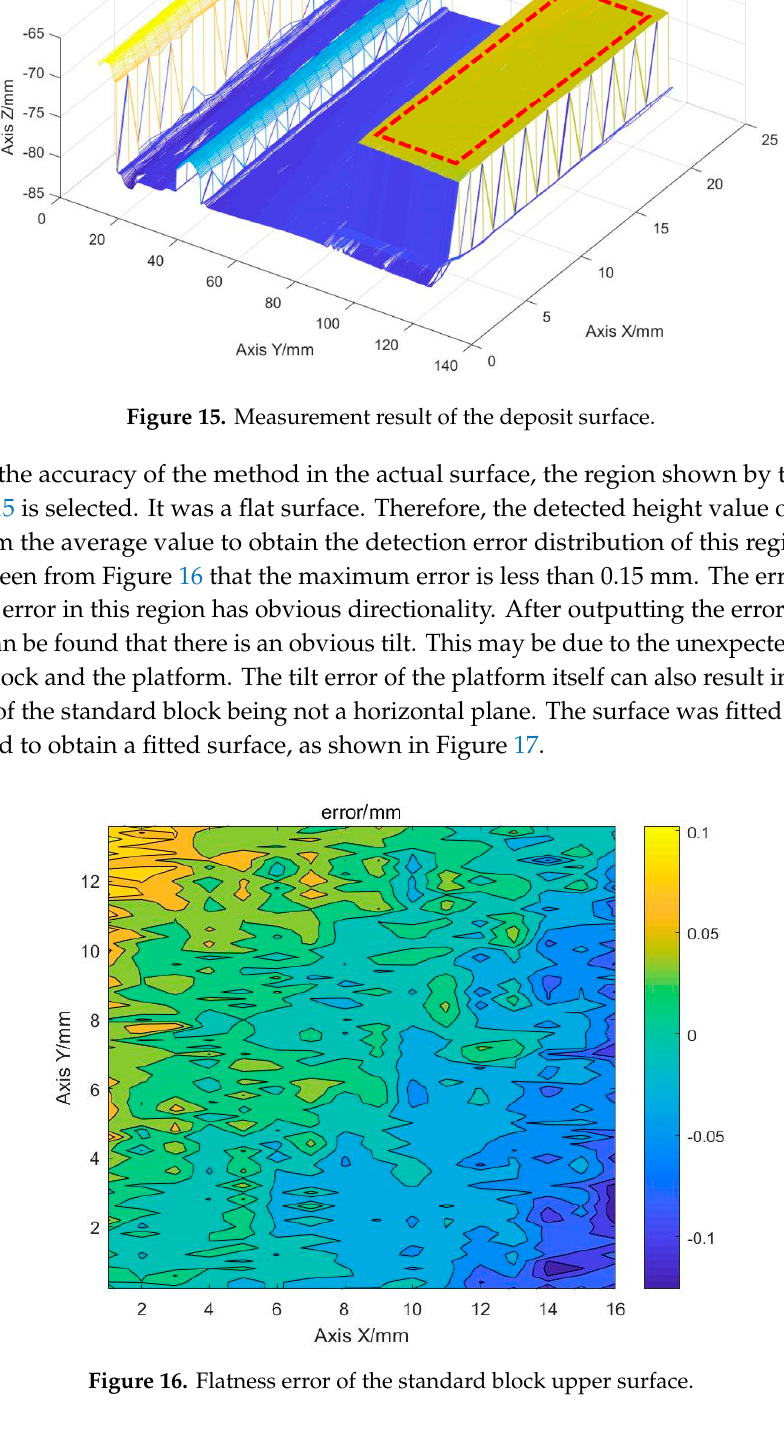
Figure 14. Configuration of the online measurement system.